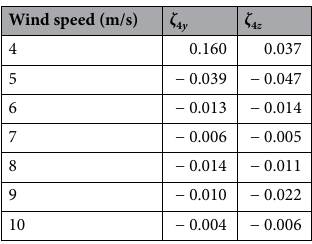
Table 4. Damping ratios of the 4th mode for 15° wind